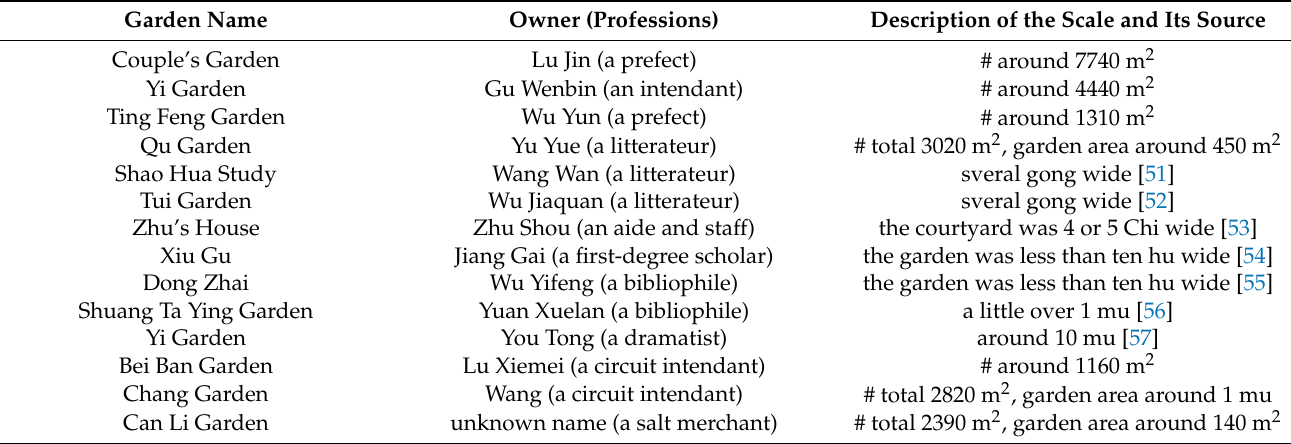
Table 4. Scale Table of Private Gardens in the Qing